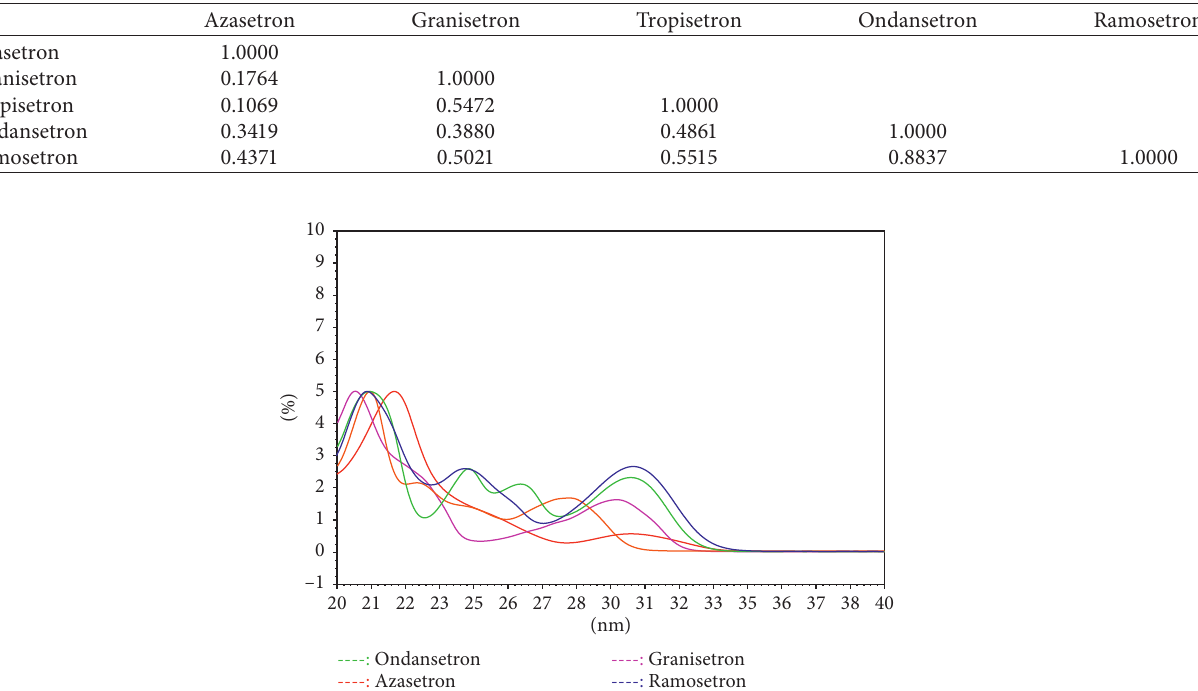
Table 4: 1st UV spectra similarity of the five 5-HT3 receptor antagonists.